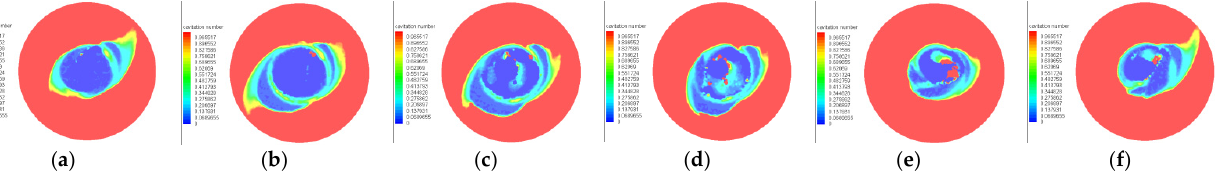
Figure 18. When inlet pressure = 15 MPa, gap = 1.5 mm, the variation of cavitation number of the original suction cup with time in adhesion interface plane at: ( a ) 5 ms, ( b ) 9.4 ms, ( c ) 13.8 ms, ( d ) 18.2 ms, ( e ) 22.6 ms, ( f ) 27 ms.